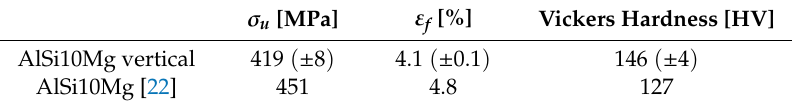
Table 2. Results of the tensile tests and of the Vickers hardness